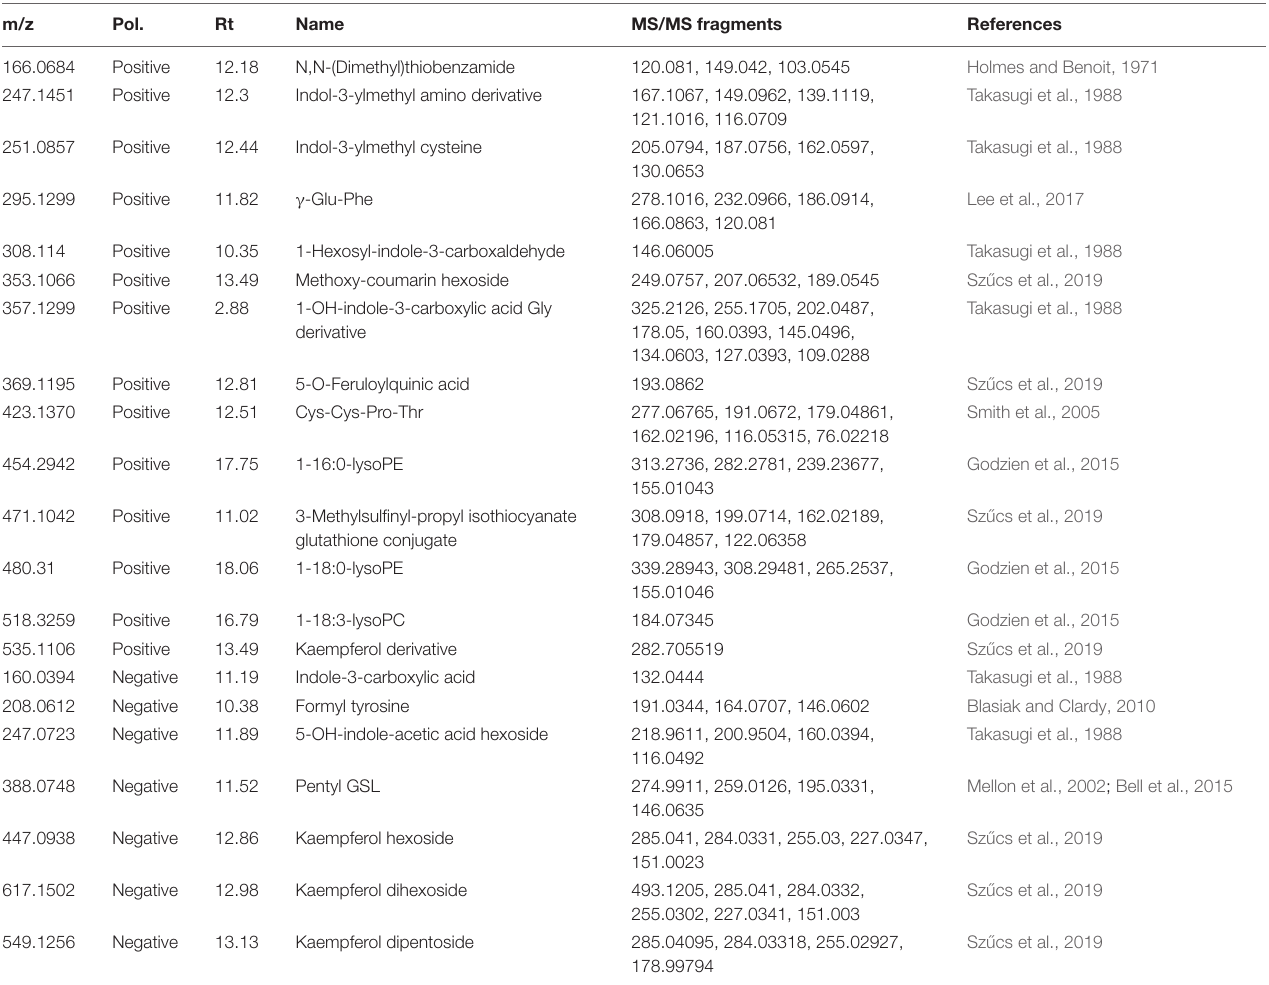
TABLE 1 | Compounds identified at MSI level 2 from horseradish